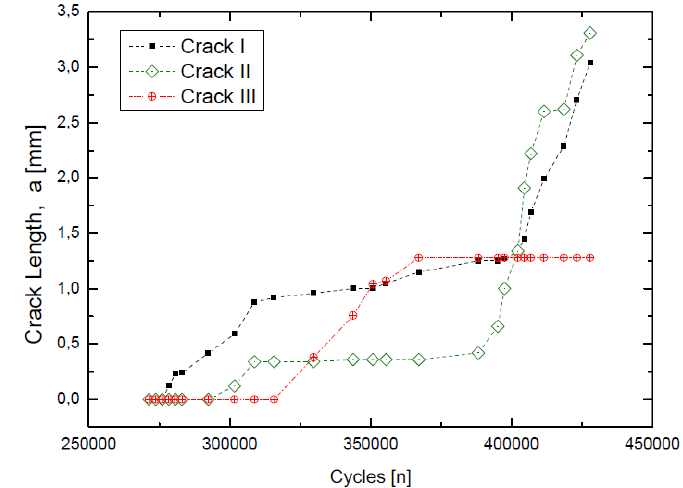
Figure 4: Crack length in relation to number of cycles.